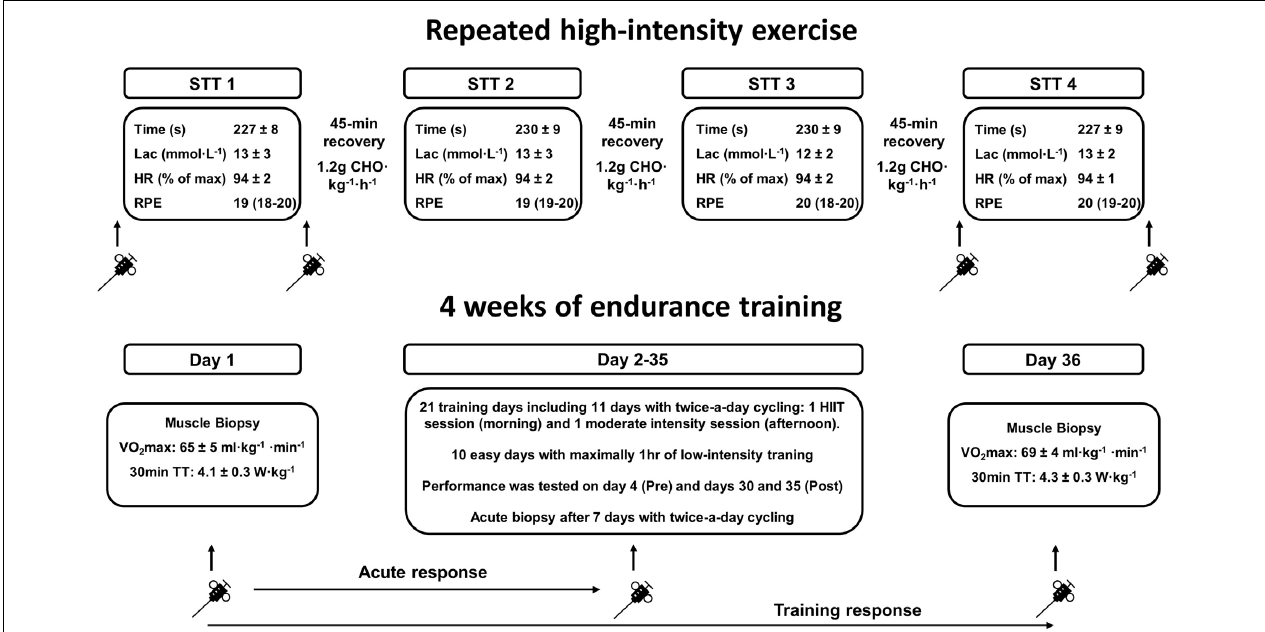
FIGURE 1 | Overview of the study protocol employed to examine the response of calcium handling by the sarcoplasmic reticulum in the muscles of the arms and legs to exercise. The (upper) section illustrates the four maximal 1300-m sprint time-trials (STT 1–4), separated by 45-min periods of recovery with intake of carbohydrate (CHO), performed by highly trained cross-country skiers, as well as associated analyzes. Muscle biopsies were obtained before and after the first (STT1) and fourth time-trials (STT4). Information about the time required to complete (time), blood lactate concentration (Lac) immediately after completion, average heart rate (HR) and RPE during each STT have been reported previously [values are mean ± SD, and for RPE as median (range)] (Andersson et al., 2016). The (lower) section illustrates the “real-life” training day and subsequent 34-day period of training by highly trained triathletes and road cyclists (described in detail in the section “Materials and Methods”). Information about changes in performance (i.e., VO2max and power output during the 30-min time-trial) following this training period have also been reported previously (Gejl et al., 2017b).